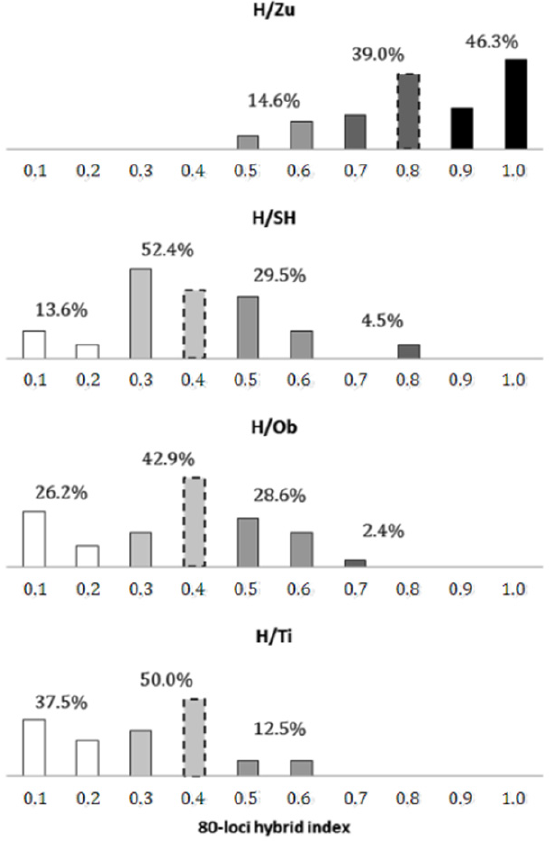
Figure 3. Frequency distribution of individual forms within putative hybrid swarms P. sylvestris x mugo in Slovakia. Genotypes considered as parental taxa are shown in black ( P. sylvestris ) and white ( P. mugo ), while introgressant and intermediate forms are shown in gray shades. The dashed bars represent the mode localizations as determined above. presented in the (supplementary material Figure